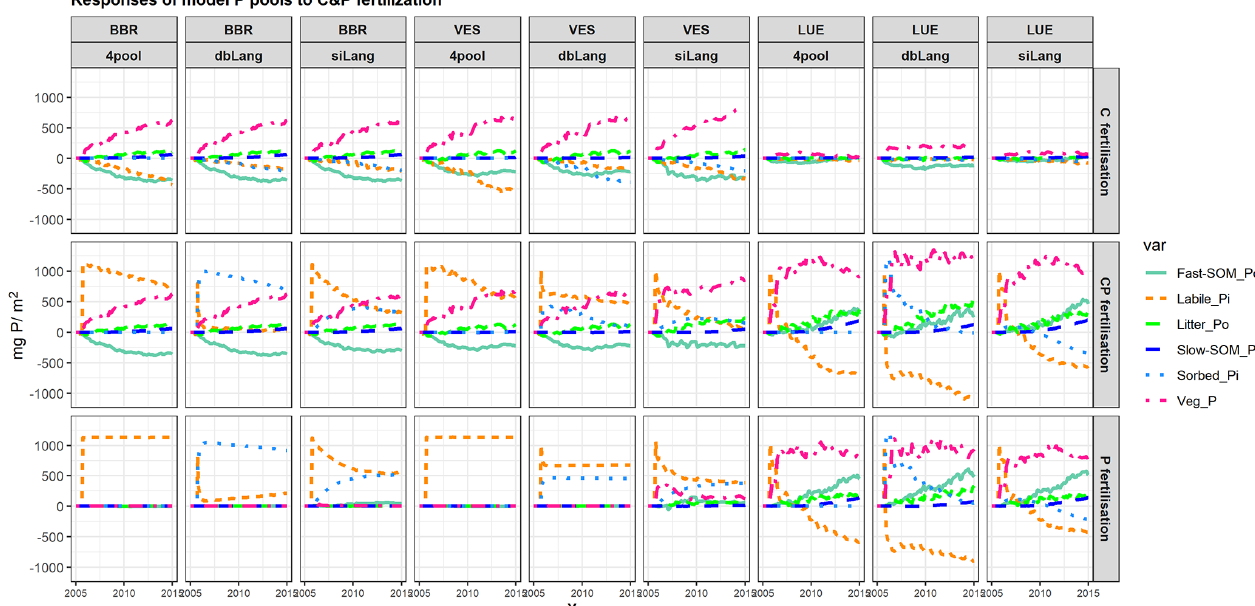
Figure 7. Simulated temporal responses of model P pools (labile Pi; sorbed Pi; litter Po; Po in fast and slow soil organic matter (SOM) pools – fast-SOM_Po and slow-SOM_Po, respectively; and P in the plant – Veg_P) to CO 2 , P, and CP fertilizations at the BBR, VES, and LUE sites. In the C fertilization experiment, the atmospheric CO 2 concentration was increased by 200ppm from 2006 to 2015. In the P fertilization experiment, 1139.7mgPm − 2 was added once to the soil as soluble phosphate on 16 September 2006. The CP fertilization is the combination of C and P fertilizations. Each point in the x axis represents a P budget change at the specific time, with the size change in all P pools equal to zero (C fertilization) or the added P (1139.7mgPm − 2 , P and CP fertilization). The change in a specific P pool at any given time is equal to the total change in related P fluxes since the fertilization (e.g., the plant P pool change relates to plant P uptake and P litterfall, the labile Pi pool change relates to P adsorption (and P absorption) (Fig. 1), the Po in the fast SOM pool change relates to litter and fast SOM decomposition, and so